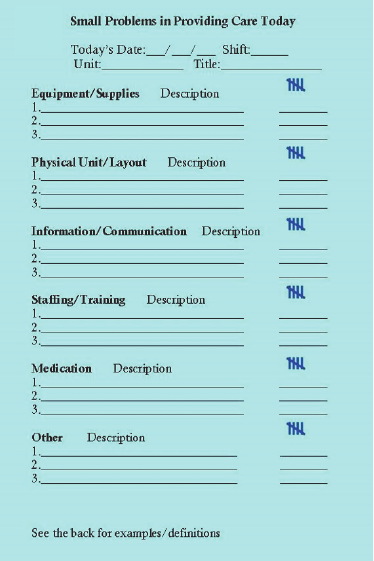
Figure 1: STAR Pocket Card (2008 copyright Stevens &